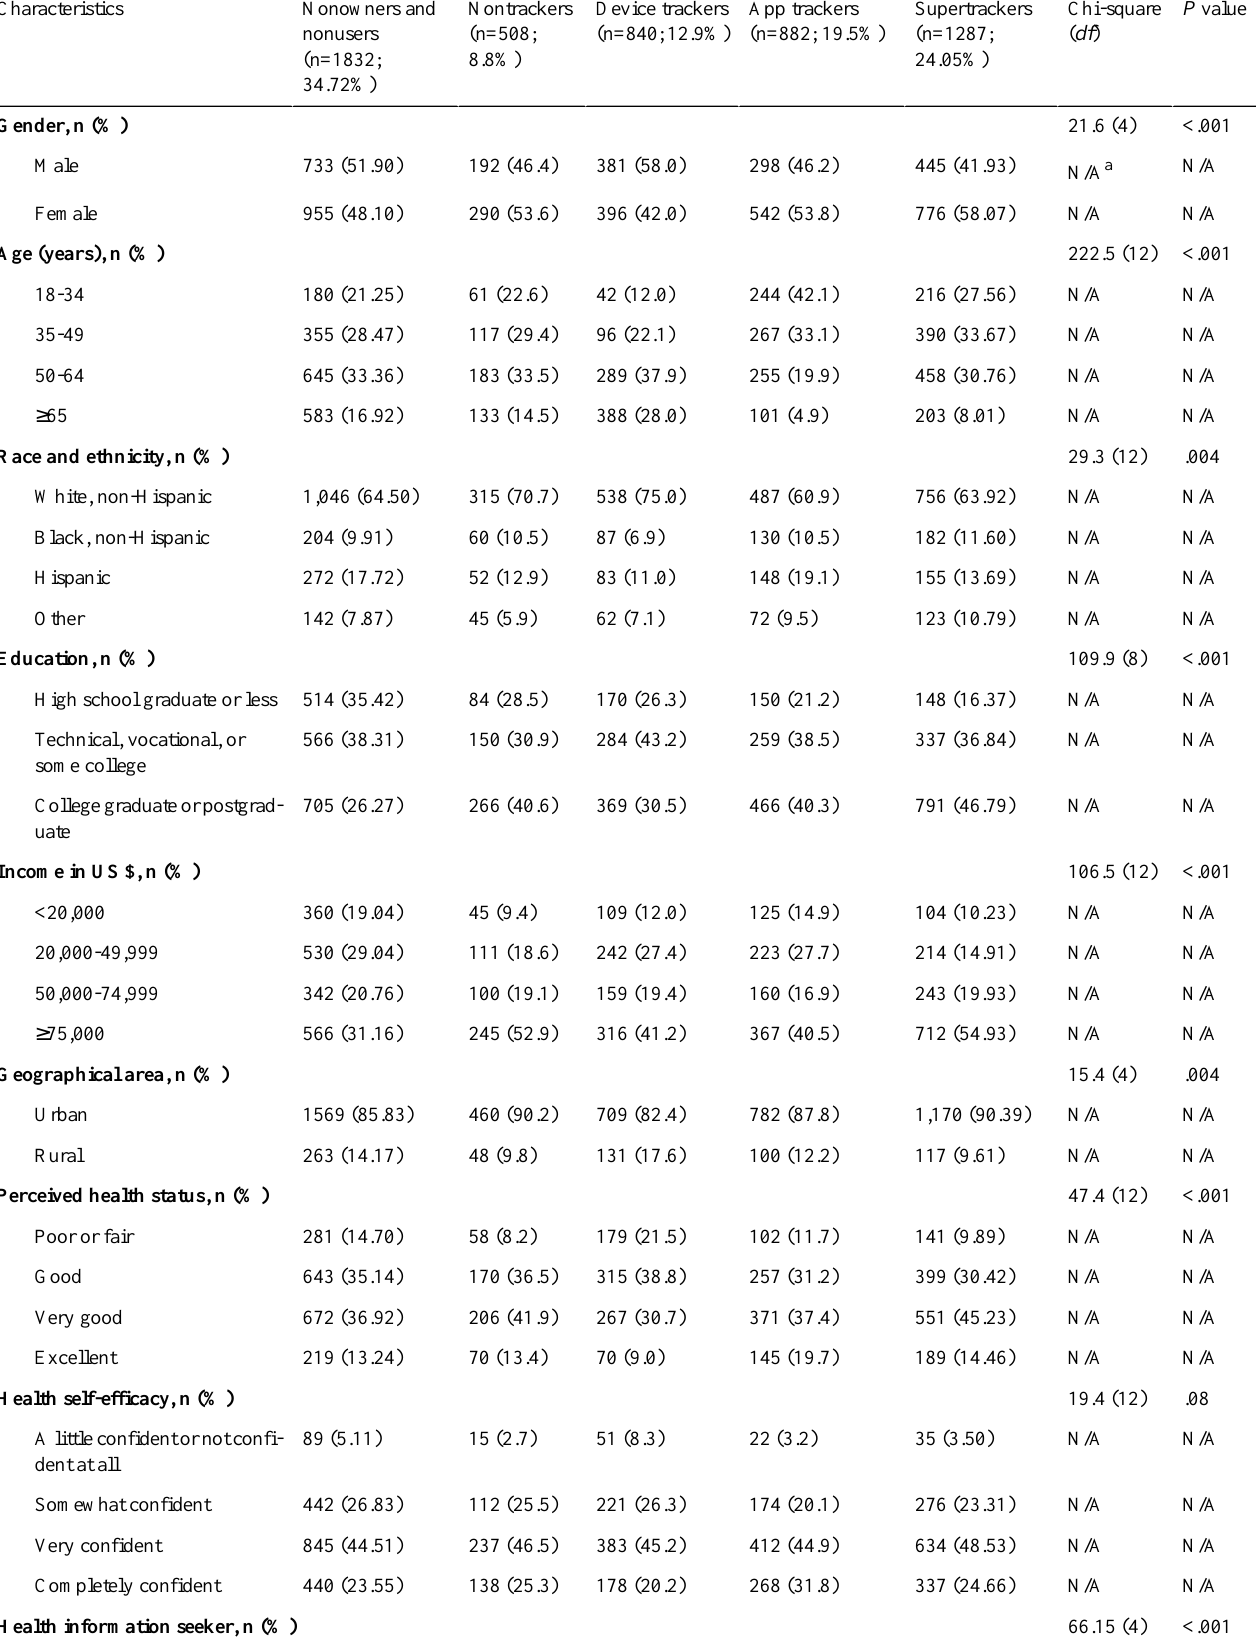
Table 1. Weighted population estimates for sociodemographic and health-related characteristics by pattern of mobile health use for health and behavioral tracking; HINTS 5, Cycle 1, 2017 and Cycle 2, 2018